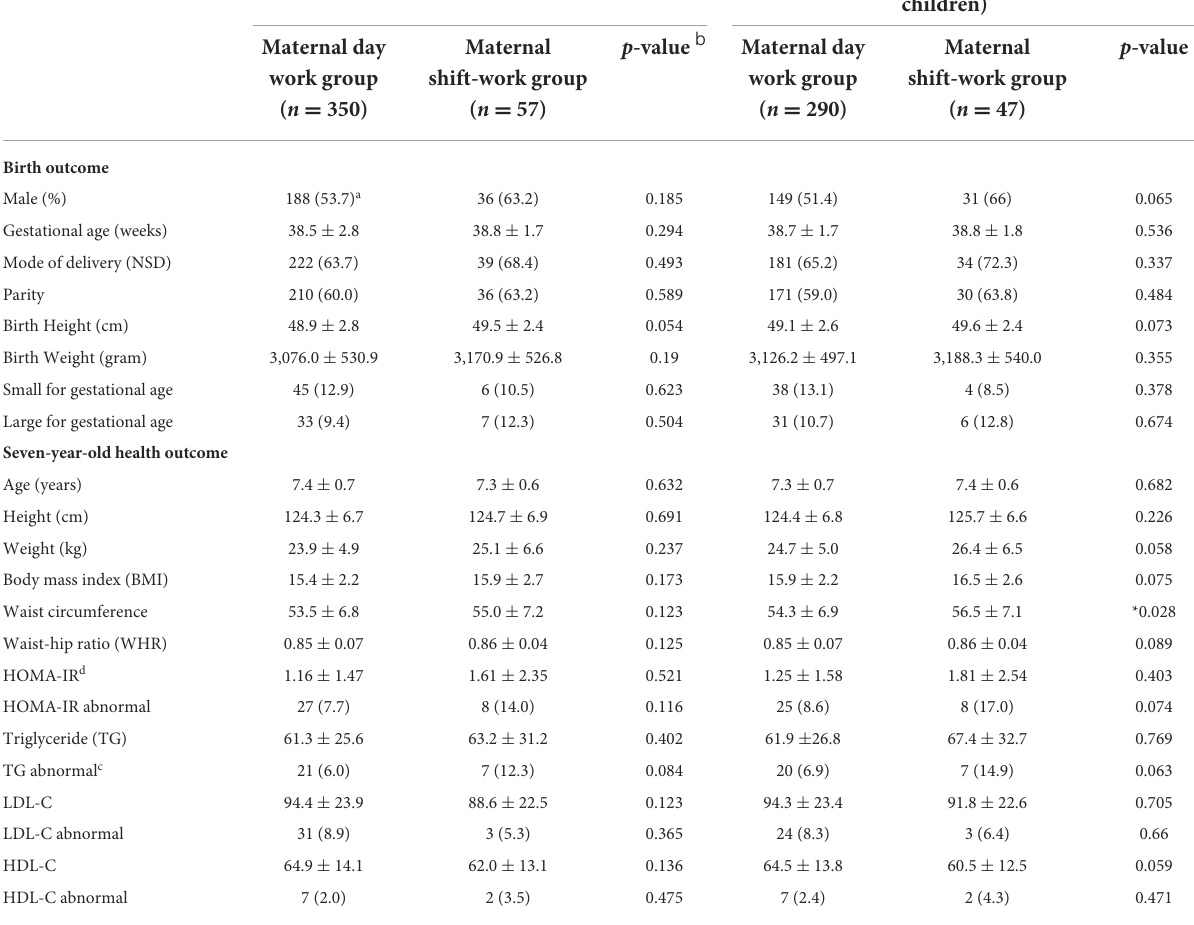
TABLE 2 Birth and 7-year-old health outcomes of children.